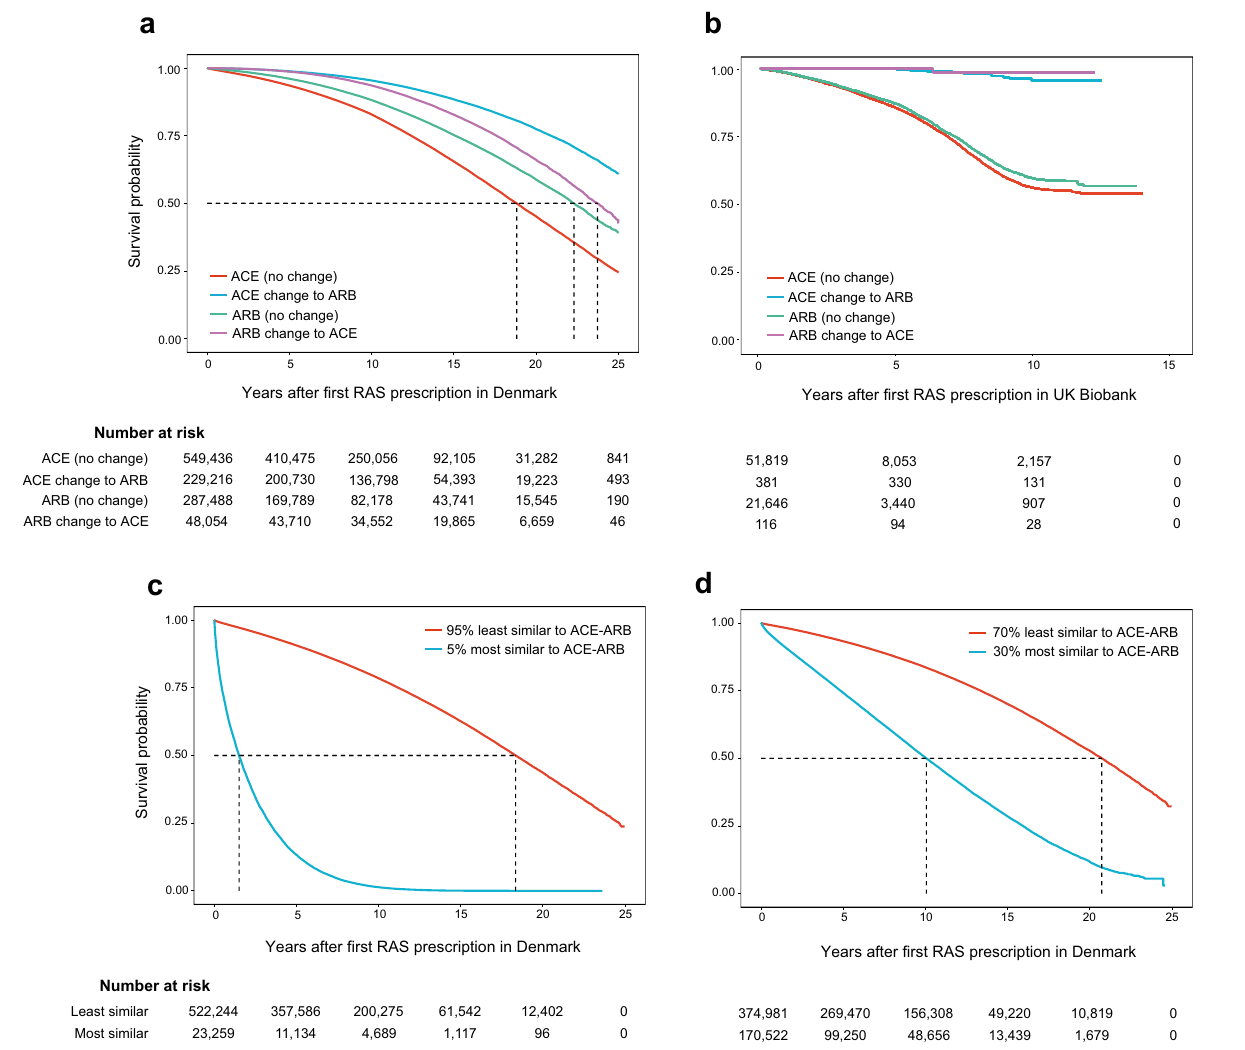
Fig. 4 Survival curves for patients treated with different RAS drugs as different lines of treatment. a Survival curves for different risk groups strati fi ed by prescription trajectories. Age, sex, and CCI adjusted Cox proportional hazard survival probability by groups of RAS treatment: i) redeeming solely ACE inhibitors with no change to ARB; ii) redeeming ACE inhibitors with posterior change to ARB; iii) redeeming uniquely ARB(s) with no change to ACE; and iv) redeeming ARB(s) with posterior change to ACE. The hazard ratio (HR) is lower for all individuals treated solely with ARB or treated with ARB before or after ACE when compared to individuals treated with ACE with no change to second line treatment. b Survival curves for the same groups of patients in the UKBB. c 95th percentile most similar ACE patients to AC – -ARB trajectories survival vs. ACE patients less similar to ACE – ARB. d Seventieth percentile most similar ACE patients to ACE – ARB trajectories survival vs. ACE patients less similar to ACE –